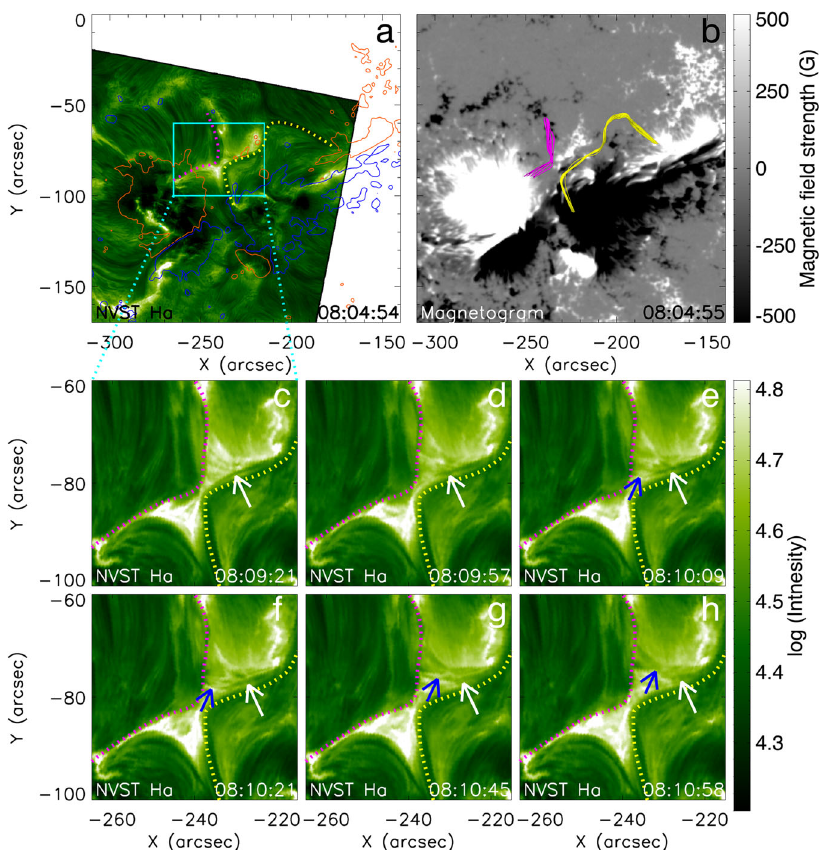
Fig. 1 Involvement of the fi lament in magnetic reconnection during the con fi ned fl are, as observed by the NVST in the center of the H α line. a H α image at 08:04:54 UT, superimposed by the line-of-sight magnetogram from SDO/HMI at 08:04:55 UT, with positive (red) and negative (blue) contours drawn at ±500 G. The dotted yellow and pink lines mark the fi lament and relevant chromospheric fi brils, respectively. b SDO/HMI line-of-sight magnetogram with fi eld lines from the NLFFF extrapolation superimposed. The selected yellow lines trace the twisted fl ux of the fi lament. The pink lines show the relevant loops rooted in chromospheric fi brils. c – h Reconnection of a fi lament thread in the current sheet. White arrows indicate the thread, fi rst in the in fl ow region ( c – d ), then in the out fl ow region ( g – h ). Blue arrows in e – h indicate the newly formed connection of the thread with the loops rooted in the chromospheric fi brils on the other side of the current sheet. Note that the east and west directions described in the text correspond to the left and the right sides of the Figures. Source data are provided as a Source Data fi